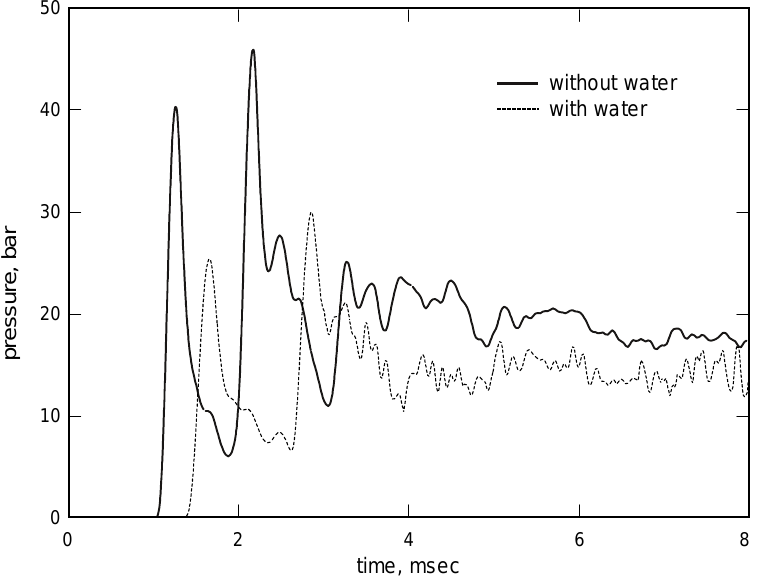
Fig. 7. Numerical simulation of pressure signatures at pressure point P2 in the tunnel system. Table 5 Peak shock pressure for 375 g TNT detonation in the tunnel